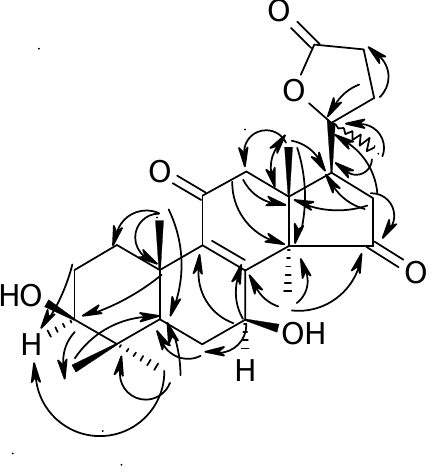
Figure 2. key HMBC( ) correlations of Ganolactone B ( 1